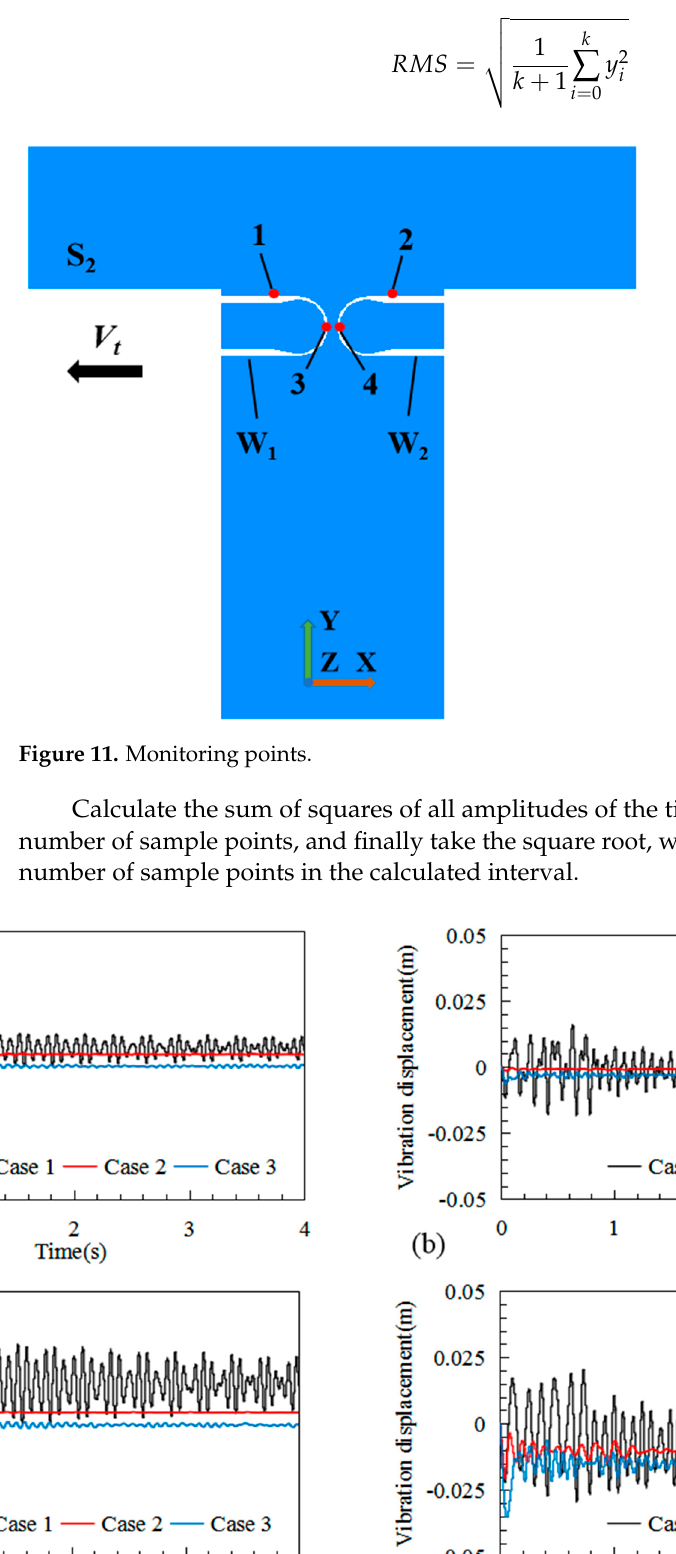
surface are significantly greater than those in Case 2 and Case 3. As the thickness of the straight walls on both sides of the outer windshield capsule is greater than the arc top, and the straight walls on both sides of the capsule are connected with the mounting bracket, the fluctuating amplitude of points d1 and d2 is smaller than that of points d3 and d4 in the middle of the arc of the U-shaped capsule. At the initial stage of the dy- namic response of the outer windshield, there is not yet a dynamic balance stage between aerodynamic force, inertial force, and elastic force, which causes the vibration amplitude to change significantly with time, such as within 0~1 s of the vibration stage. When the interaction among aerodynamic force, inertial force, and elastic force reaches a dynamic balance, the amplitude and period of vibration remains relatively stable. Table 3 shows the average and RMS values for the displacement measuring points in the two dynamic response stages, and quantitatively compares the displacement and vi- bration intensity between the three external windshield schemes. According to the data in the table, the maximum displacement of external windshield d3 in Case 1 is 15.1 mm, the maximum displacement of outer windshield d4 in Case 3 is 15.8 mm, and the maxi- mum displacement of outer windshield in Case 2 is 10.4 mm, less than that in Case 1 and Case 3. The vibration displacement direction of the rubber external windshield can be